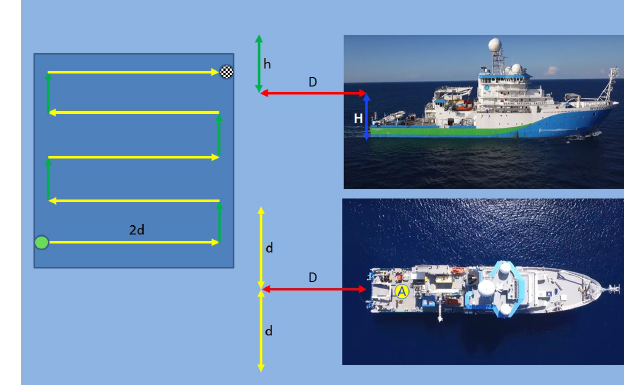
Figure 1. The UAV system with the on-board instrumentation: the DISCmini and the IAQ-calc. Figure 2. Flight path used to capture the plume: H – height from the ocean, D – distance behind the ship to the flight beginning point, h – rising altitude after the horizontal transect, 2 d – full length of the horizontal